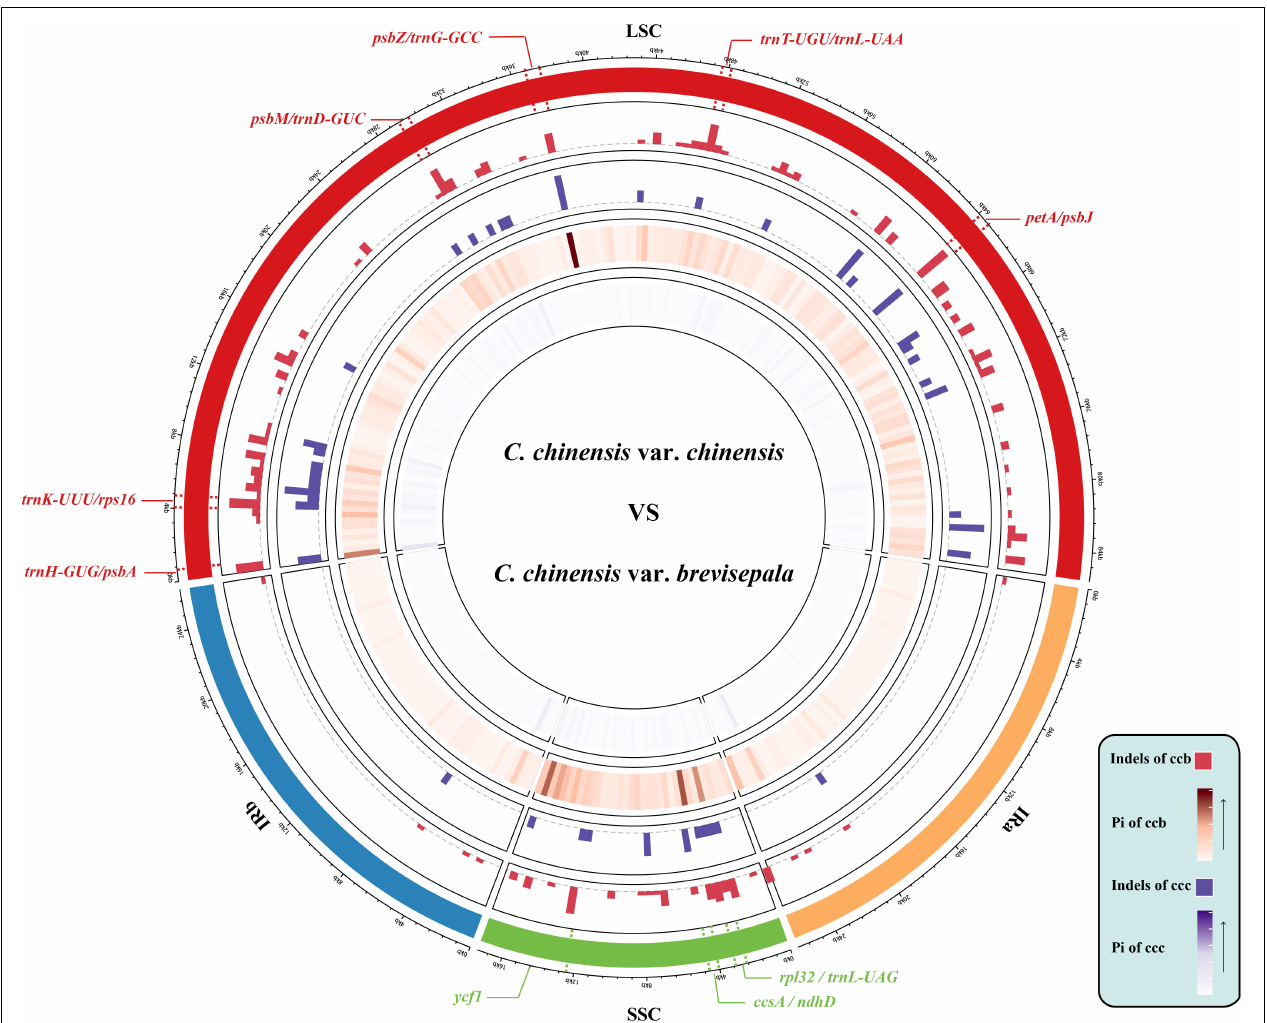
FIGURE 2 | Circos plot showing the indel and nucleotide diversity of wild and cultivated C. chinensis . The concentric circles from outer to inner indicate the following: quadripartite structure of the plastid represented by different colors; the indels of Ccb; the indels of Ccc; the nucleotide diversity of Ccb; and the nucleotide diversity of Ccc. All statistics were computed for windows of 500 bp. In the Ccb population, Pi varied from 0 to 0.01442, and the average Pi was 0.00137. In the Ccc population, Pi ranged from 0 to 0.00569, and the average Pi was extremely low (approximately